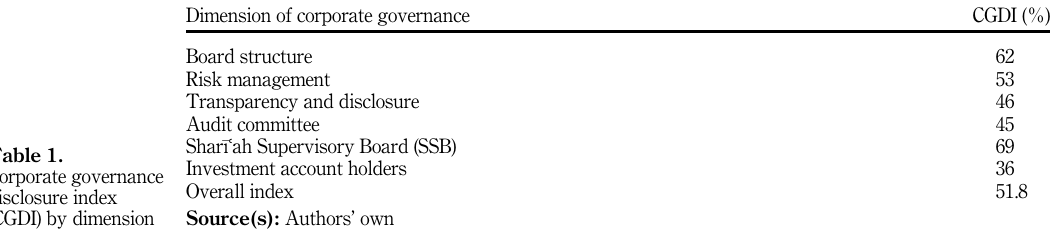
disclosure index (CGDI) by